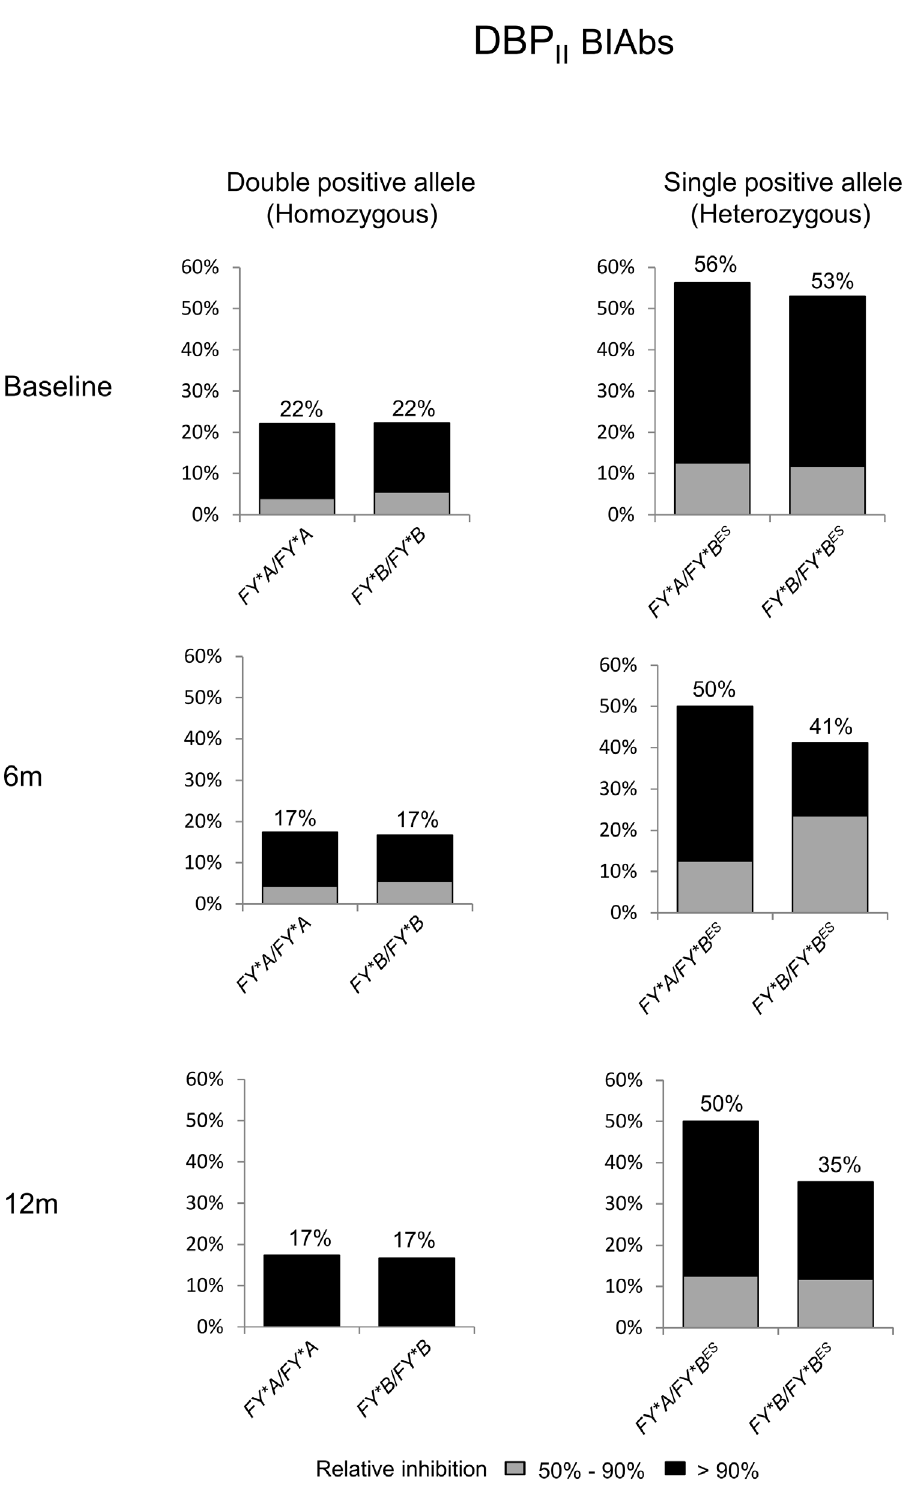
Figure 4. Homozygosis for either the FY*A or FY*B allele is associated with low frequency of DBPII BIAbs. Plasma samples were grouped according to DARC genotype, as described in legend of Figure 3. DBPII BIAbs were evaluated at three consecutive surveys by COS-7 cyto-adherence assay, with plasma at 1:40 and DBPII –DARC binding inhibition $ 50% considered positive inhibition. doi:10.1371/journal.pone.0093782.g004 [47], we found no difference in the inhibitory responses between to block parasite invasion [36]. Here, the DBPII/DARC the FY*A and FY*B homozygotes. Recent evidence suggests that interaction was assessed by using the established COS-7 cyto- FY*A allelic polymorphism affects the ability of PvDBP antibodies adherence assay based upon a multivalent interaction between